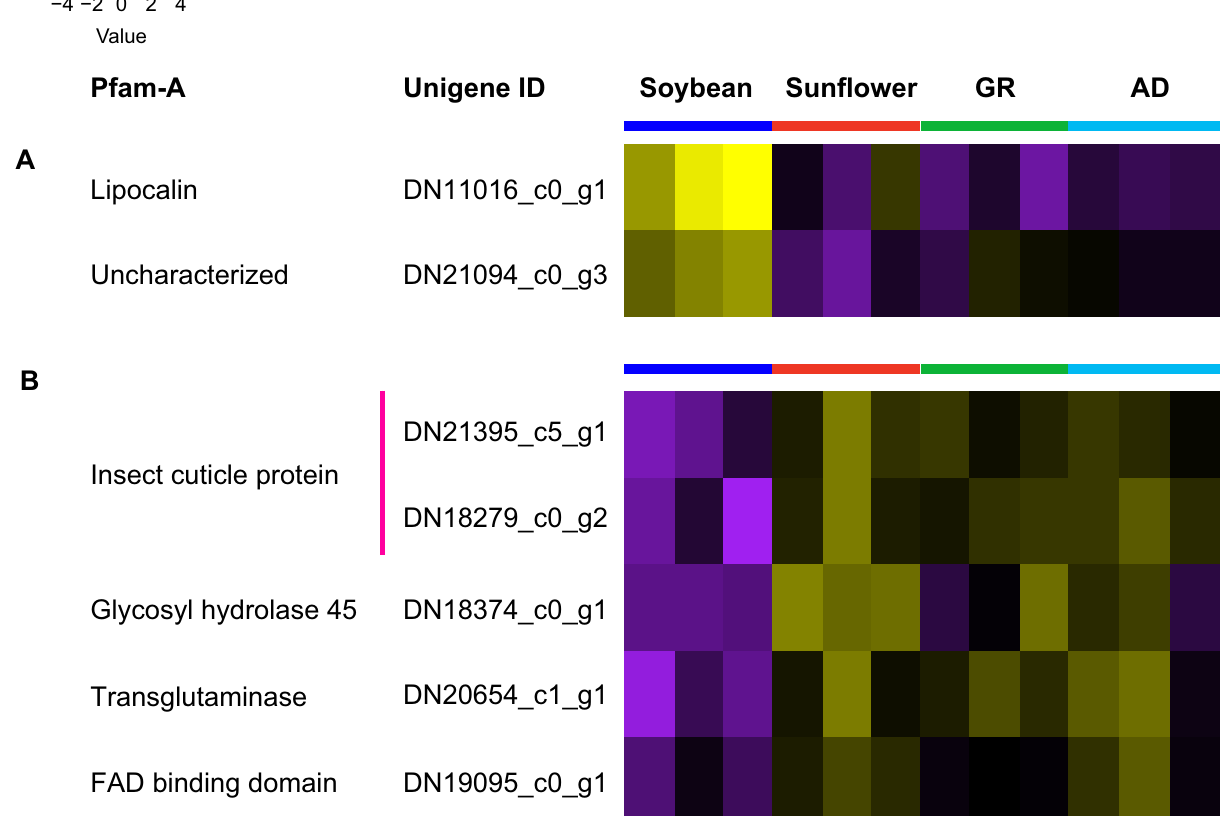
Figure 6. Heatmaps of unigenes expressed at ( A ) higher and ( B ) lower levels in larvae fed soybean compared to those fed sunflower, giant ragweed, and artificial diet by K-means analyses. Each row represents a separate unigene. Yellow and purple indicate high and low expression levels, respectively (Fold change > ± 1.5, False Discovery Rate < 0.05). Pfam-A = Protein family-A domain; FAD = Flavin adenine